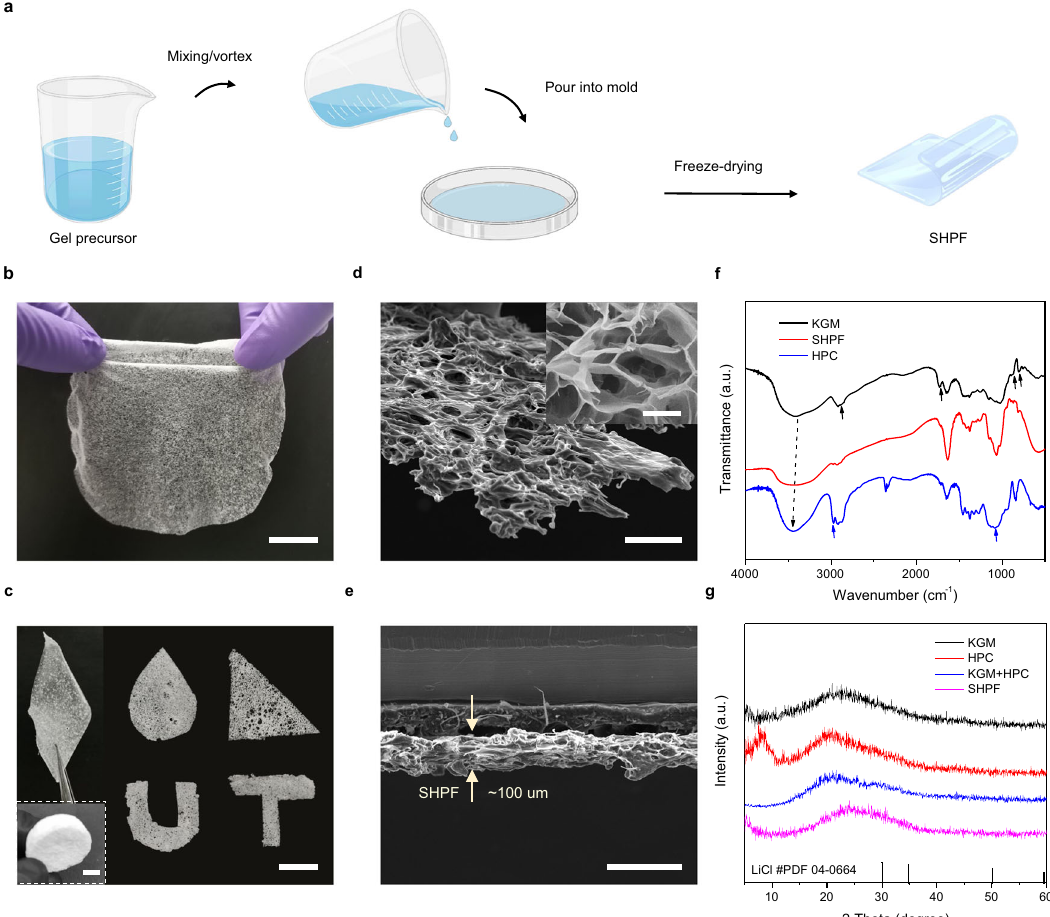
Fig. 2 Fabrication and characterization of SHPFs. a Fabrication of an SHPF via a casting method. b Photograph of a wafer-scale SHPF. Scale bar: 2 cm. c Photographs of SHPFs with different shapes and thicknesses. Scale bars: 1 cm. d SEM image of SHPF. Scale bar: 200 µ m. The Inset shows the enlarged porous structure of SHPH. Scale bar: 20 µ m. e Cross-sectional view of SHPF showing an average thickness of ~100 µ m. Scale bar: 200 µ m. f FTIR spectra of KGM (black curve), HPC (blue curve), and SHPF (red curve). g The XRD patterns of KGM (black curve), HPC (red curve), KGM + HPC (blue curve), and SHPF (magenta curve). Panel a was partly generated using Servier Medical Art, provided by Servier, licensed under a Creative Commons Attribution 3.0 unported